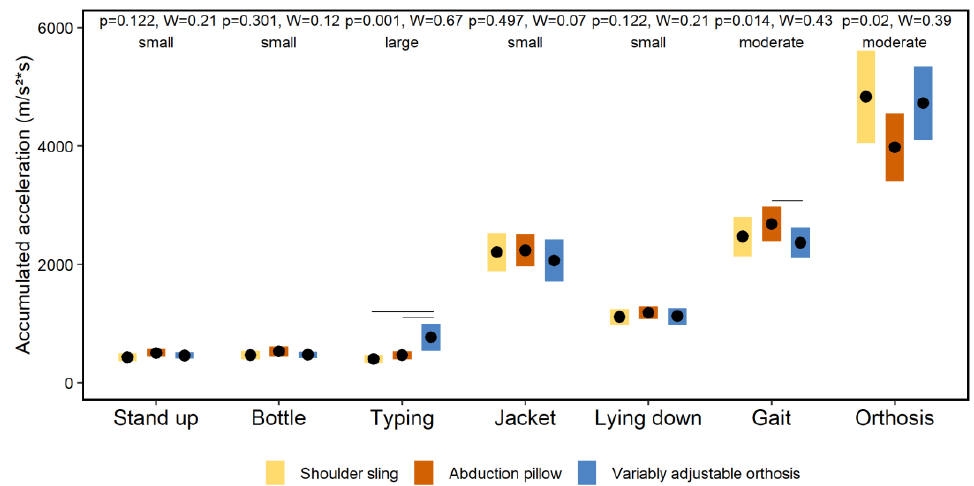
Figure 4. Effects of the orthoses on the total amount of immobilization of the shoulder joint during the activities of daily living. Note: Diamonds and bars indicate accumulated accelerations and 90% confidence intervals, respectively. Horizontal lines indicate significant post-hoc effects.